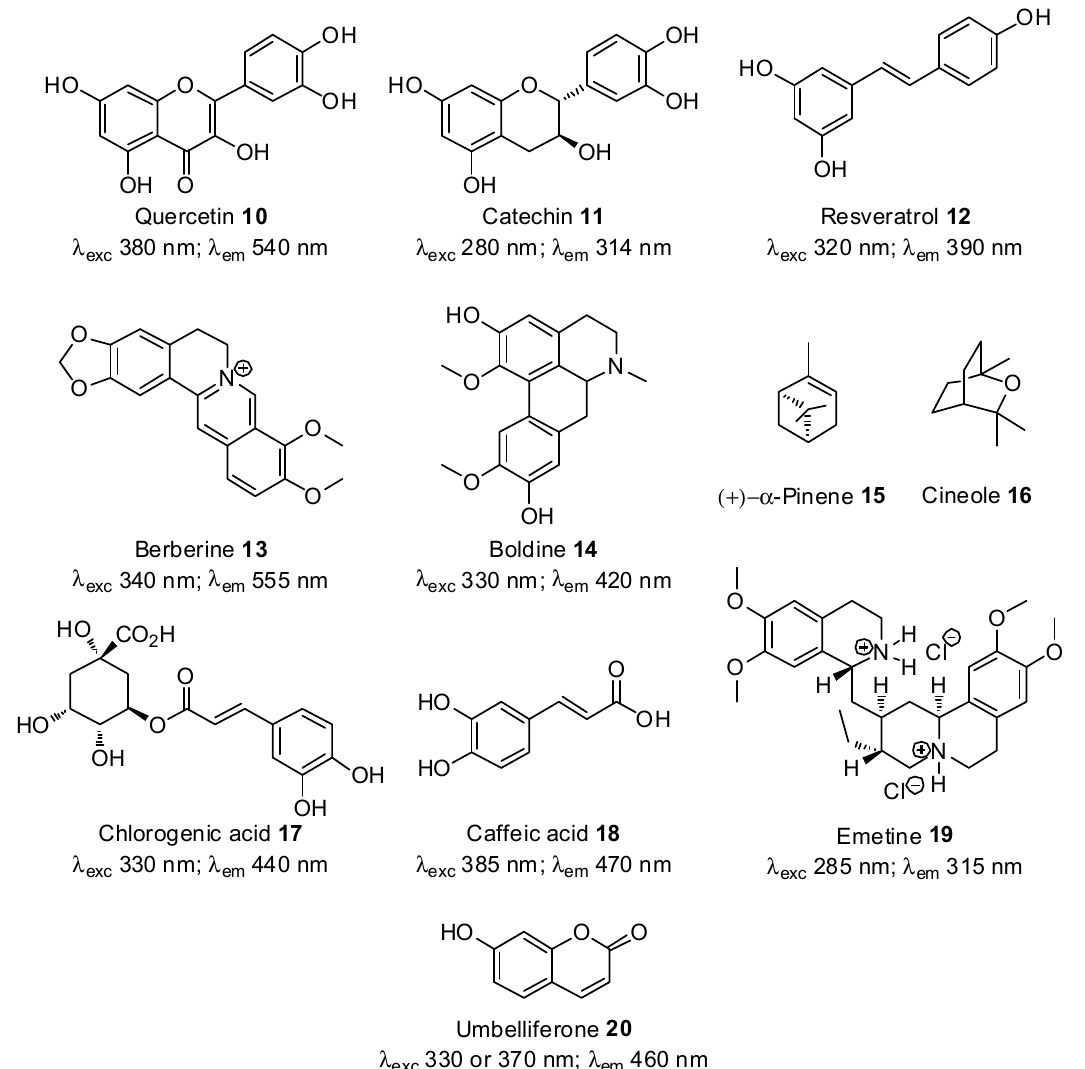
Figure 3. Tested NPs 10 – 20 and their fluorescent excitation and emission wavelengths in